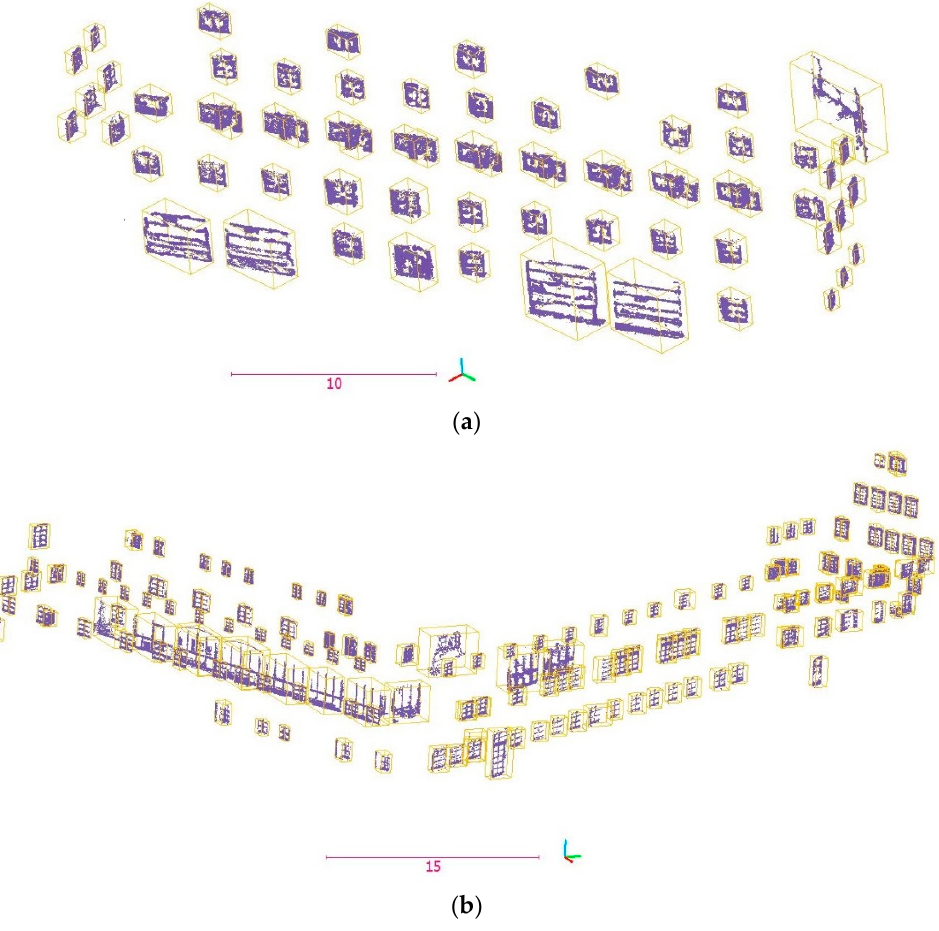
Figure 18. The extracted patches inside the bounding boxes.